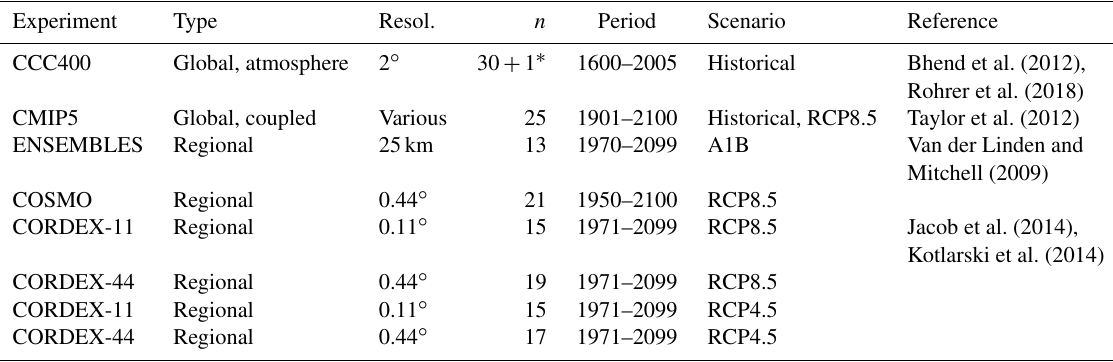
Table 1. Overview of model experiments used in our study (see Table S1 for further details). Experiment Type Resol. n Period Scenario CCC400 CMIP5 Global, coupled